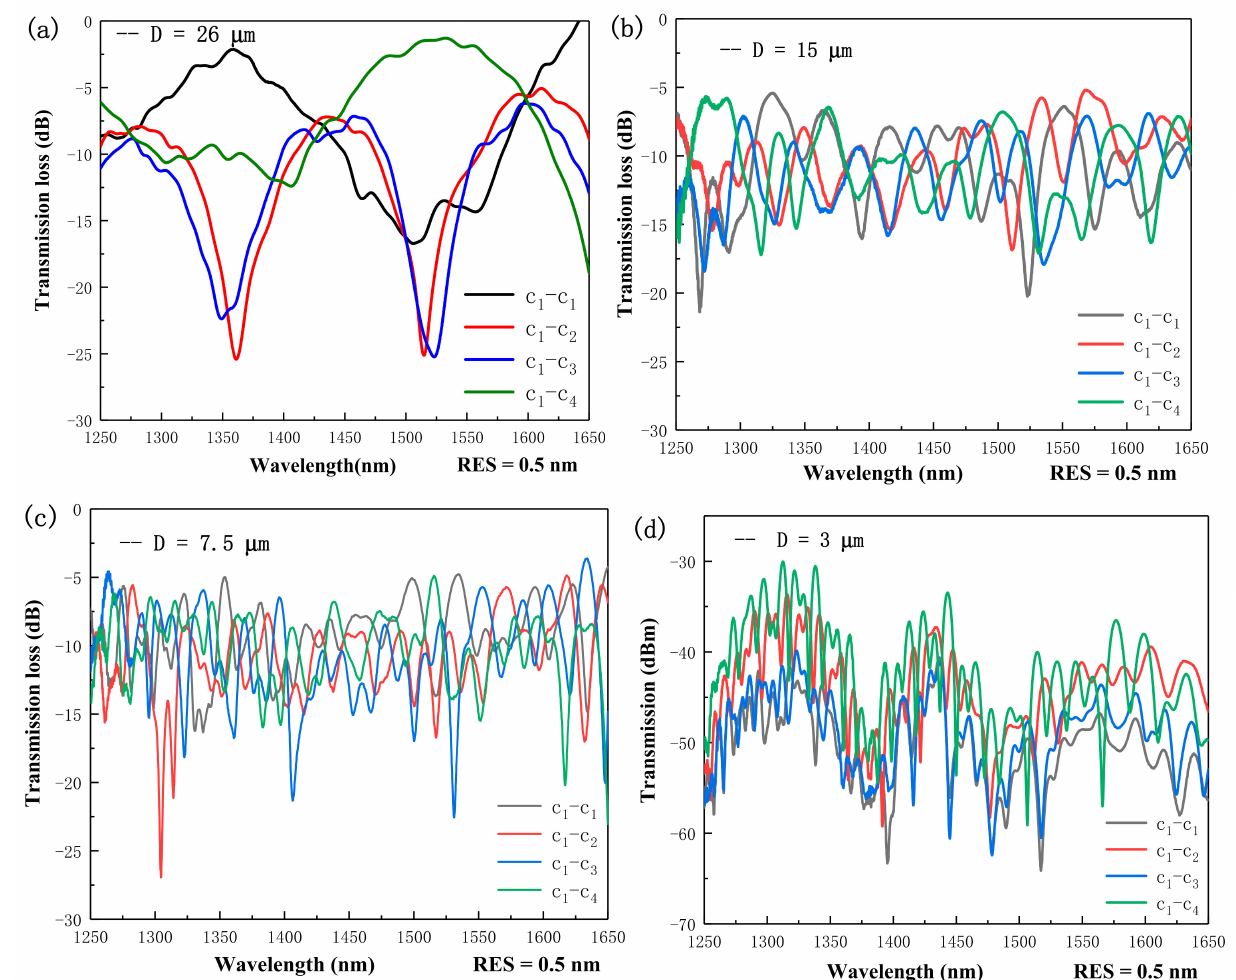
Figure 2. Spectral responses of the oscillating curves for ( a ) D = 26 µ m, ( b ) D = 15 µ m, ( c ) D = 7.5 µ m, and ( d ) D = 3 µ m, for the c 1 –c 1/2/3/4 coupling